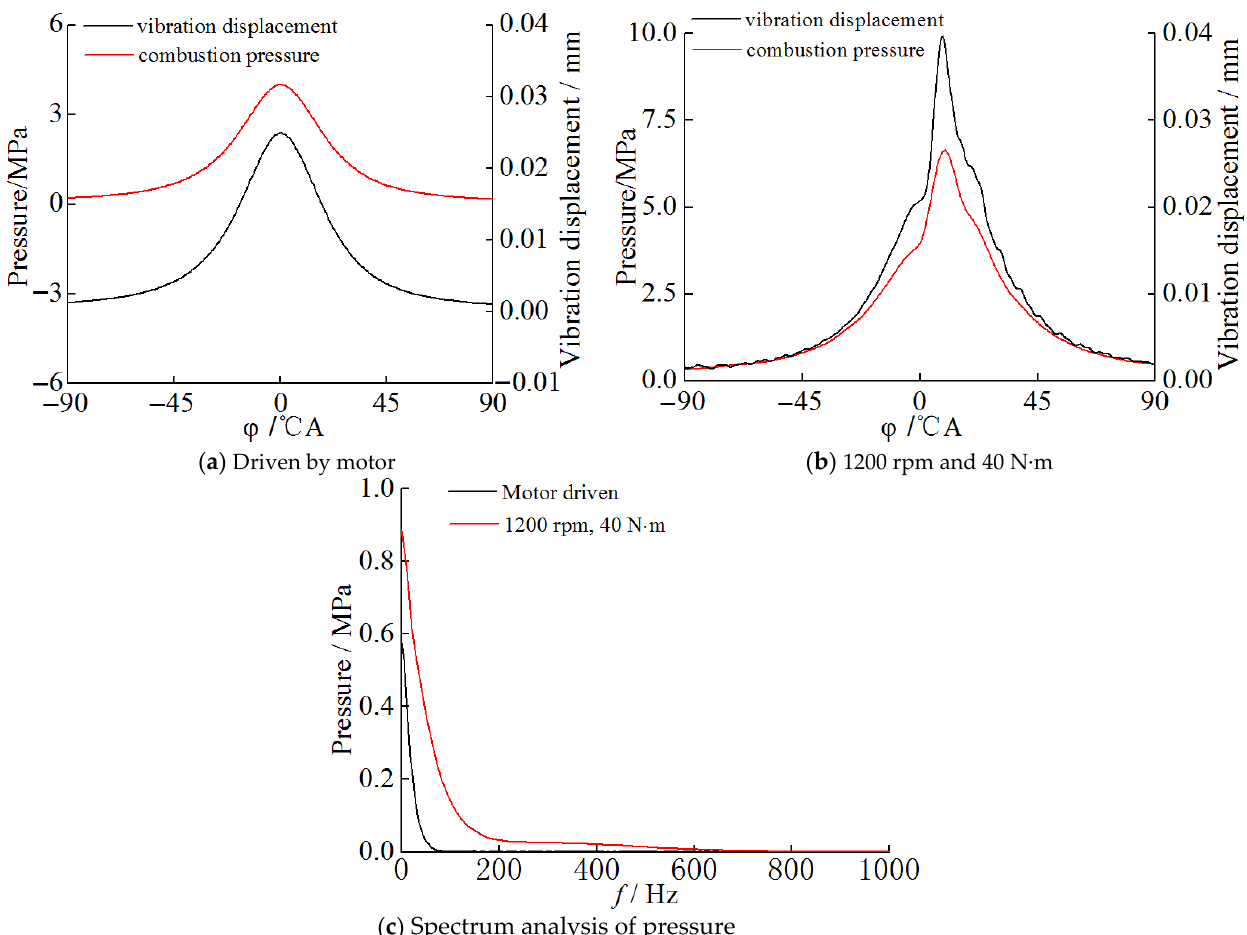
Figure 8. The time and frequency domain comparison under motor-driven and normal operating conditions.